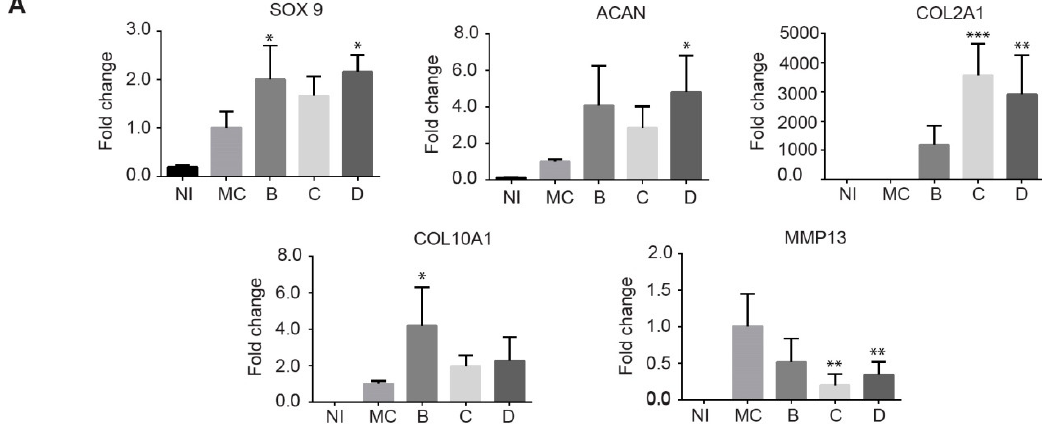
Figure 5. In vitro response of chondrocytes in biofunctionalized biphasic scaffolds. ( A )Relative gene expression of SOX9, ACAN COL2A1, COLXA1 and MMP13 . The data are reported as the mean ± standard deviation ( n = 3). * p < 0.05, ** p < 0.01, *** p < 0.001 versus MC. NI = Non-induced control, MC=Monolayer culture. Histological evaluation of Groups A to D after 28 days of culture. ( B ) Hematoxylin and eosin (H&E), and safranin O staining showing that the group consisting of fibroin/NaCl:BCM in a ratio of 1:1 showed a structural organization of the neoformed tissue similar to the native chondral tissue. ( C ) Masson’s trichrome staining showed, in the same Group B, a strong positive staining of hyaline cartilage with a good column alignment of chondrocytes, which was